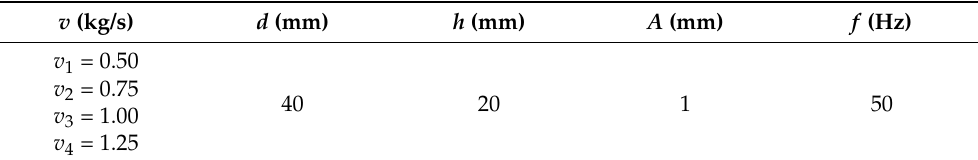
Table 4. Simulation parameters at different rice-feeding speeds.